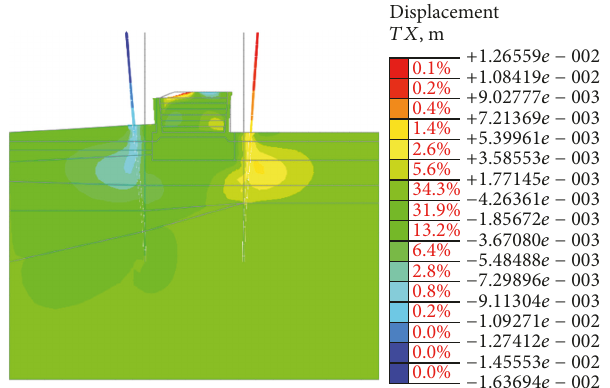
Figure 21: Profiles of bridge pile columns and lateral displacement of foundation soil-working condition 5.